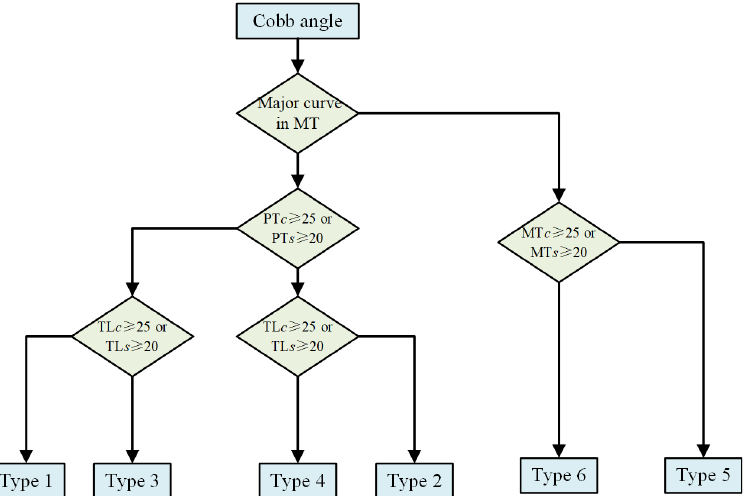
Figure 11. The automatic scoliosis Lenke classification algorithm based on Cobb angle measure- ment. PT c denotes the Cobb angle of proximal thoracic in the coronal plane; PT s denotes the